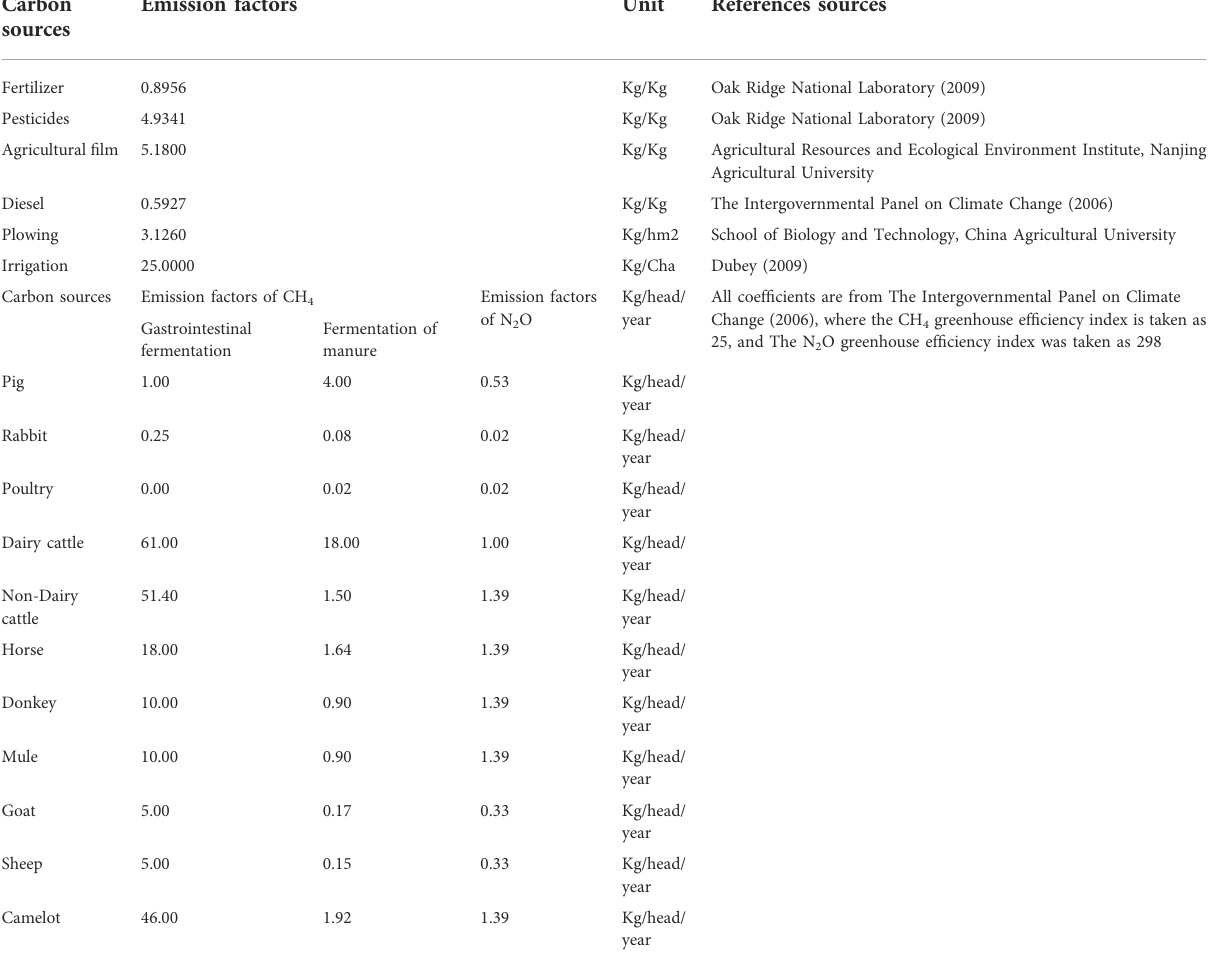
TABLE 2 Carbon sources, emission factors and sources of agricultural carbon